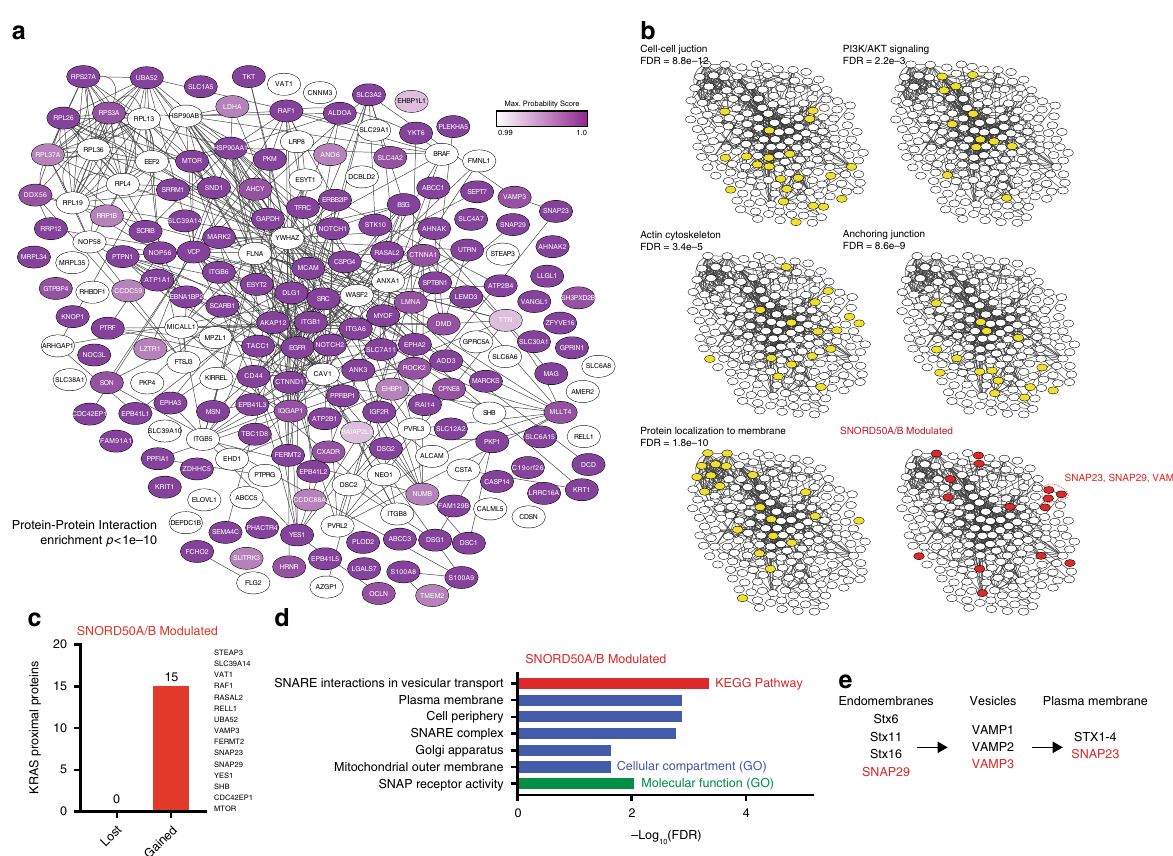
Fig. 1 SNORD50A/B shapes the proximal proteome of KRAS. a Top 197 KRAS proximal proteins identi fi ed by mass spectrometry plotted using Stringdb. Edges represent either known protein-protein interactions or pathway interactions (3 SNORD50A/B WT cancer cell lines [H23, A549, and CHL1], 6 SNORD50A/B KO clones). b Duplicate interaction networks from a highlighting the indicated annotations identi fi ed by Genemania (yellow) or by our analysis (red). c KRAS proximal proteins that are modulated by SNORD50A/B resolved by whether they are lost or gained upon SNORD50A/B knockout (SAINT probability score change of >0.25, replicable >1.5 fold change). d GO Terms and KEGG pathway interactions associated with the SNORD50A/B- modulated interactome. e Abbreviated subset of the KEGG pathway: SNARE interactions in vesicular transport. KRAS interactors identi fi ed in this study highlighted in